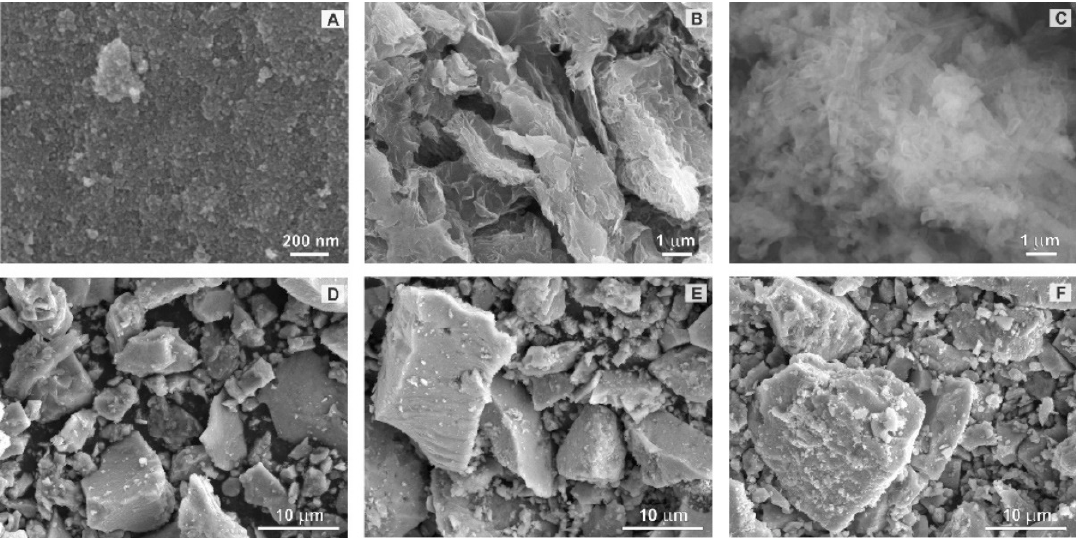
Figure 3. SEM images of ( A ) pure TiO 2 nanoparticles, ( B ) rGO, ( C ) g -C 3 N 4 , ( D ) TiO 2 /rGO, ( E ) TiO 2 /CN, and ( F ) rGO@TiO 2 /CN.